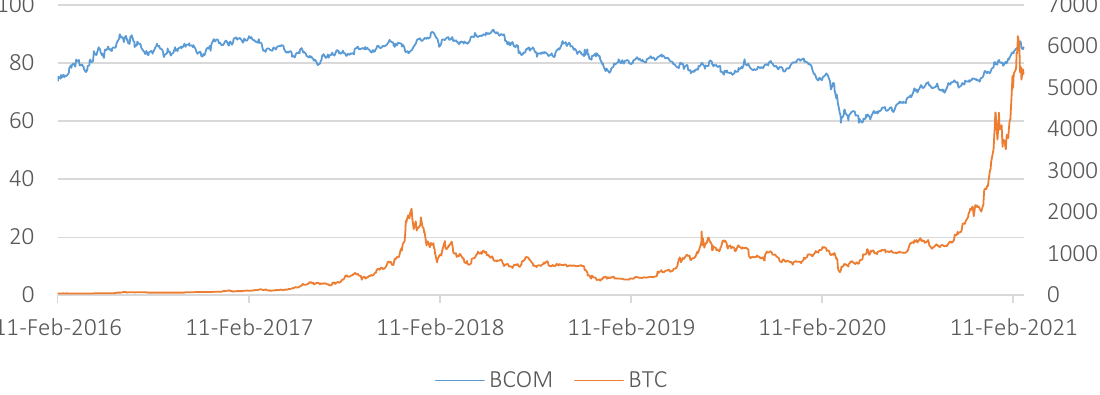
Figure 1. Bitcoin (BTC) and the Bloomberg Commodity Index (BCOM)